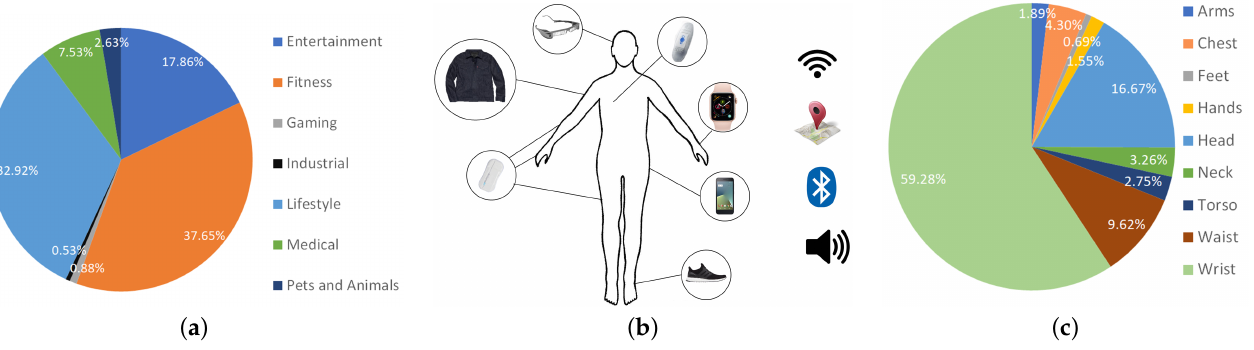
Figure 1. Wearable devices and their application. ( a ) Distribution of wearable applications [6]. ( b ) Typical wearable devices. ( c ) Distribution of wearable devices placed on common body areas